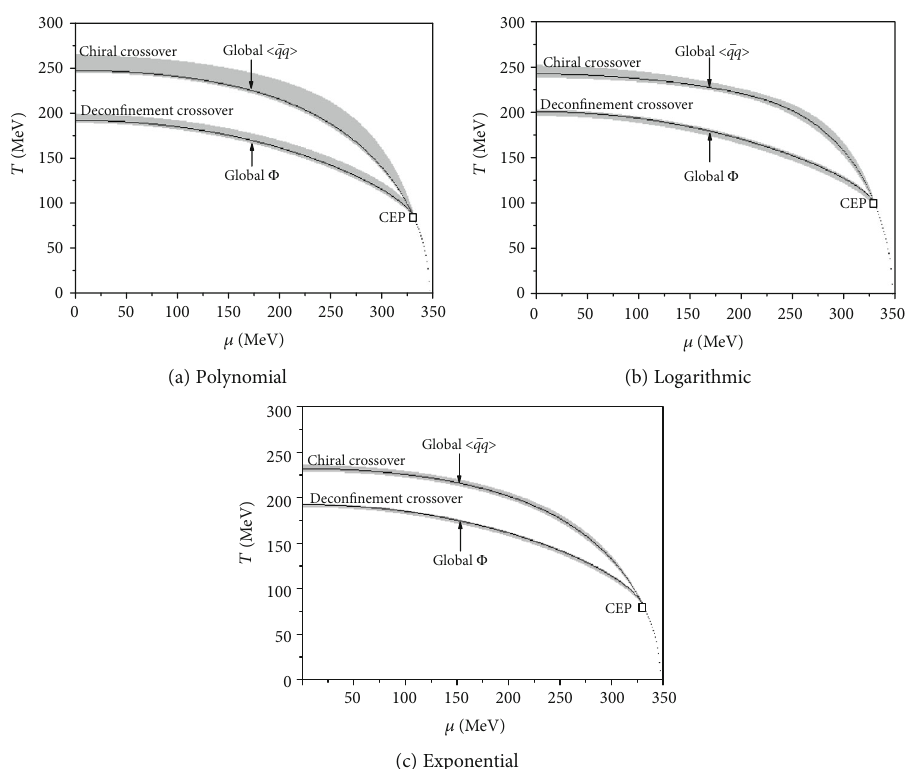
Figure 8: Phase diagram chiral and decon fi nement crossover superposition for globally based criteria.